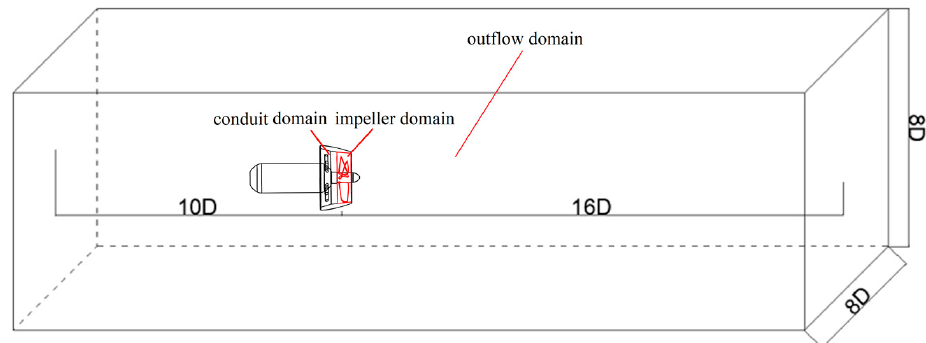
Figure 3. Computing domain.